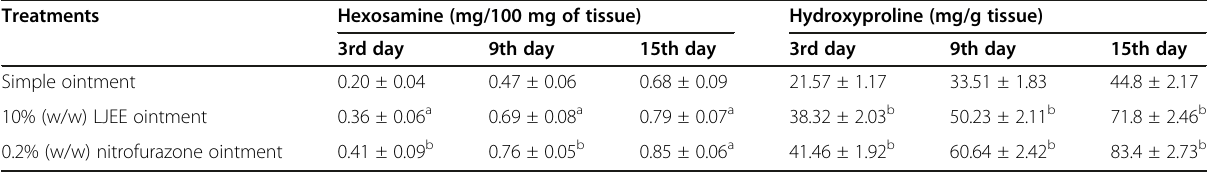
Table 2 Effects of LJEE ointment on the hexosamine and hydroxyproline content in granulation tissue on different days after wounding